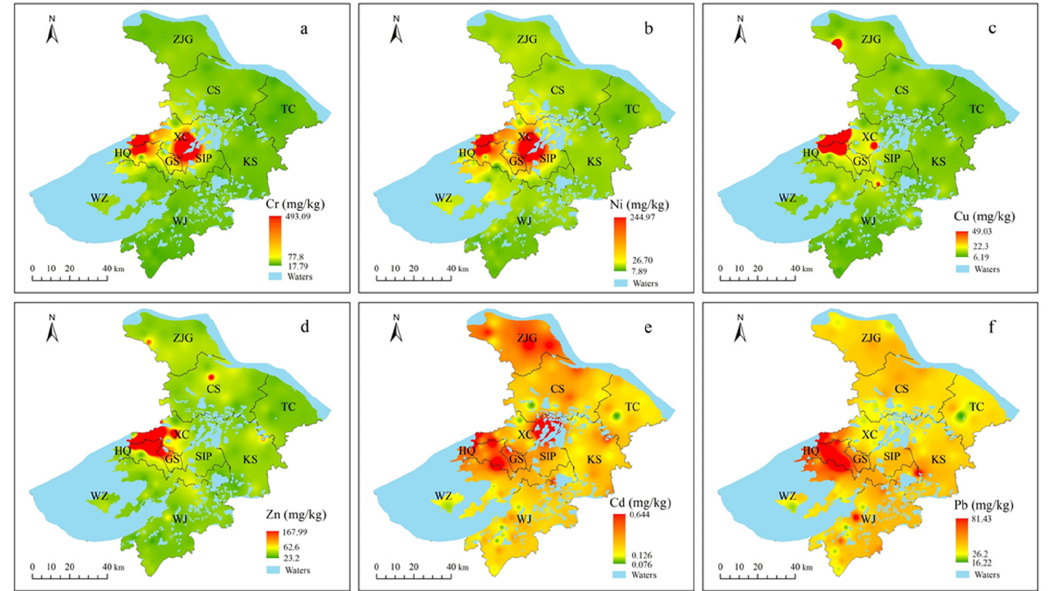
Figure 3. Spatial distribution of Gr ( a ), Ni ( b ), Cu ( c ), Zn ( d ), Cd ( e ), and Pb ( f ) concentrations in